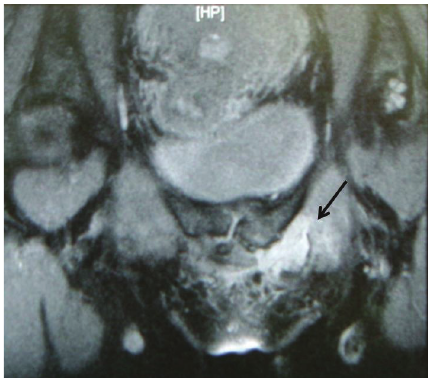
Figure 1: High signal changes in left superior pubic rami indicating bone oedema secondary to avulsion of the adductor longus tendon from its origin.